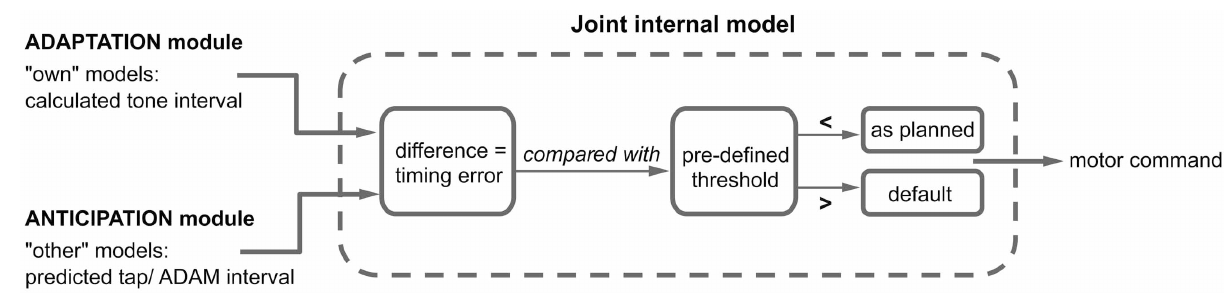
FIGURE 4 | A schematic overview of the joint internal model, where the adaptation and anticipation module interact via “own” and “other” internal models. The difference between the outputs of the adaptation and anticipation module of ADAM is compared to a